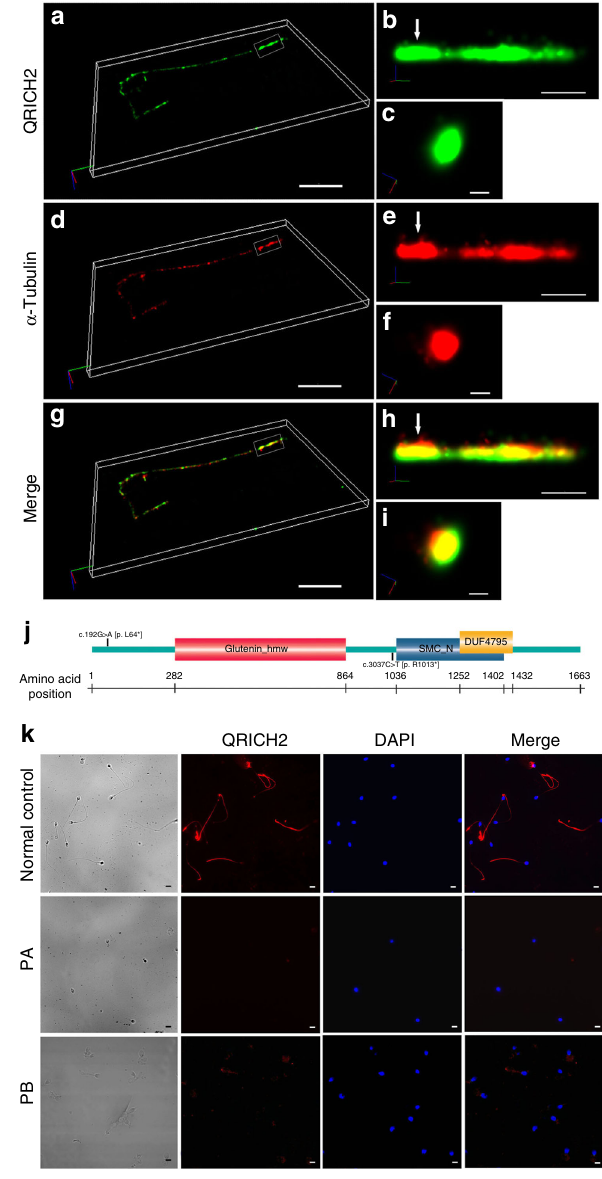
Fig. 2 QRICH2 is detected in human sperm fl agella. a – i 3D STORM images of QRICH2 (green) ( a – c ), α -Tubulin (red) ( d – f ) and their co-localization (yellow) ( g – i ). a , d , g , x - y - z projections (scale bars, 5 µ m). b , e , h , x – y projections: sections surrounded by white square (scale bars, 0.5 µ m).